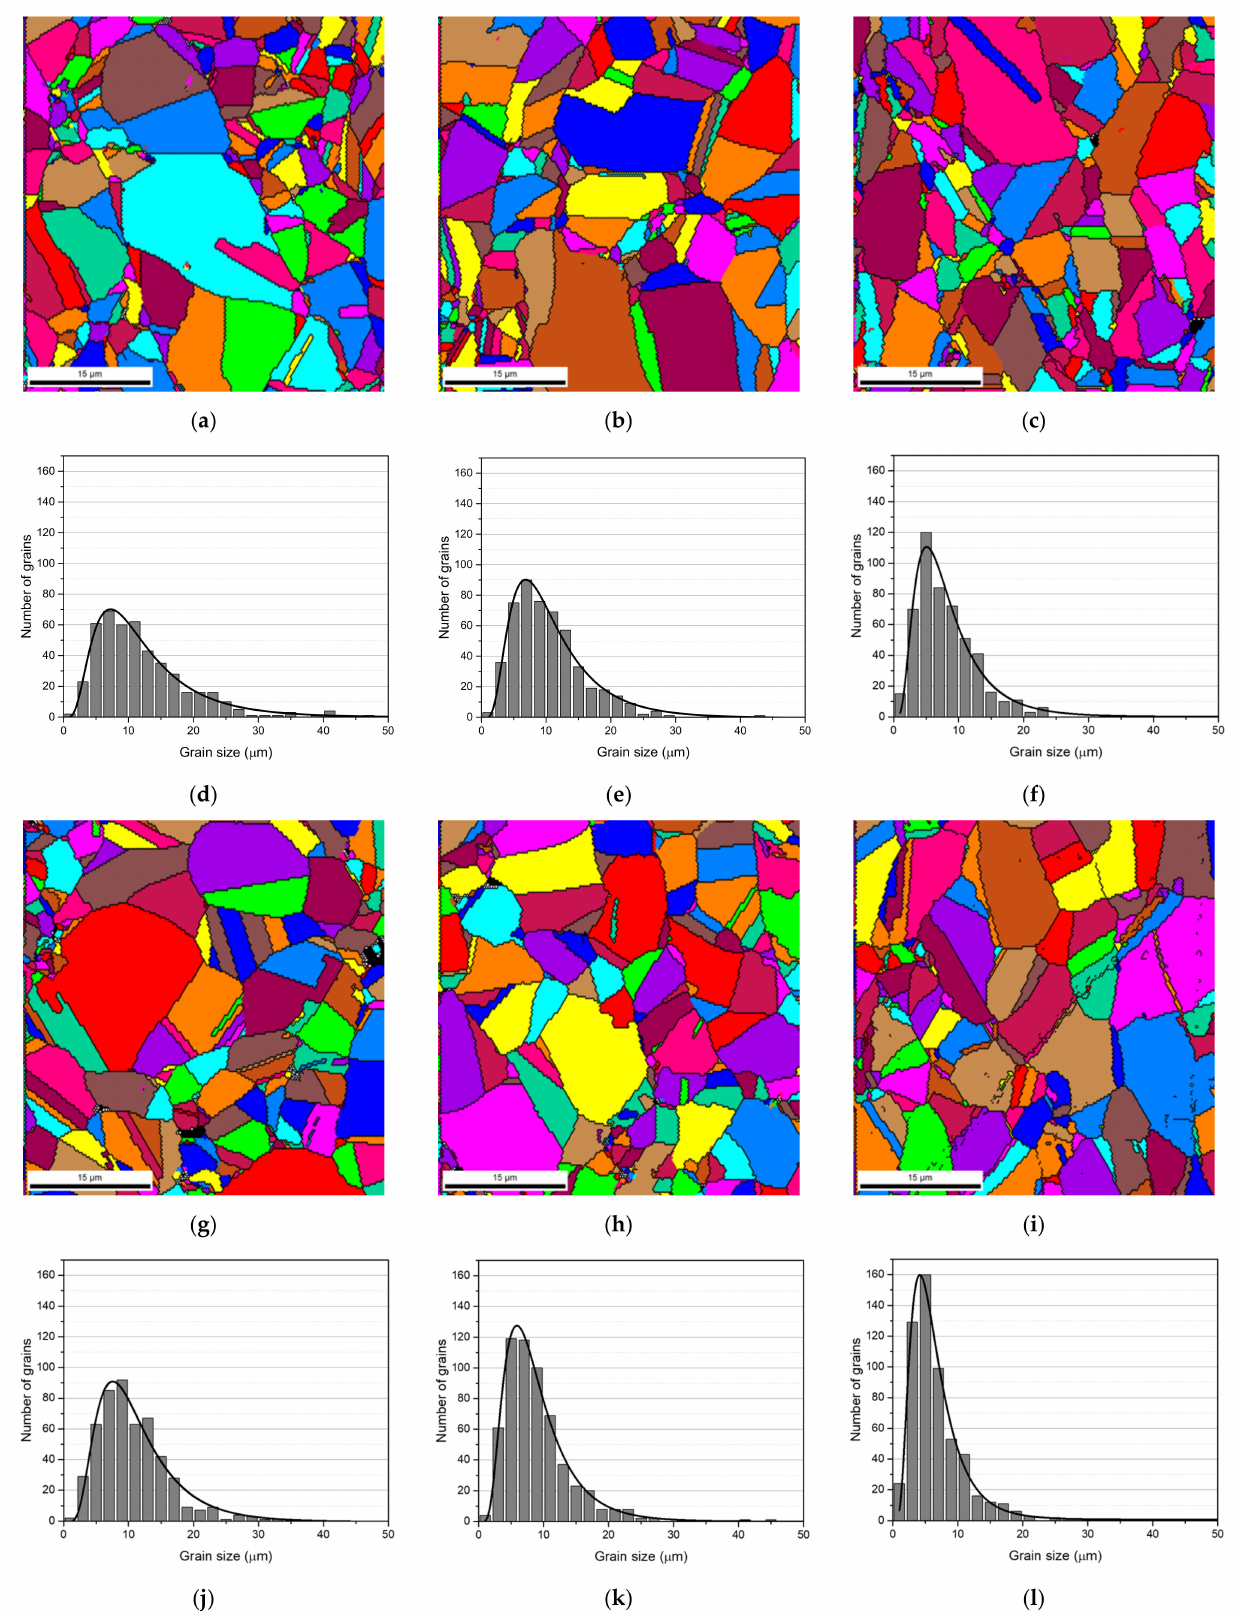
Figure 4. Grain size maps and distributions of Ni produced by ball milling for ( a , d ) 60 min, ( b , e ) 180 min, and ( c , f ) 300 min, and of Ni-CNT produced with ( g , j ) 60 min, ( h , k ) 180 min, and ( i , l ) 300